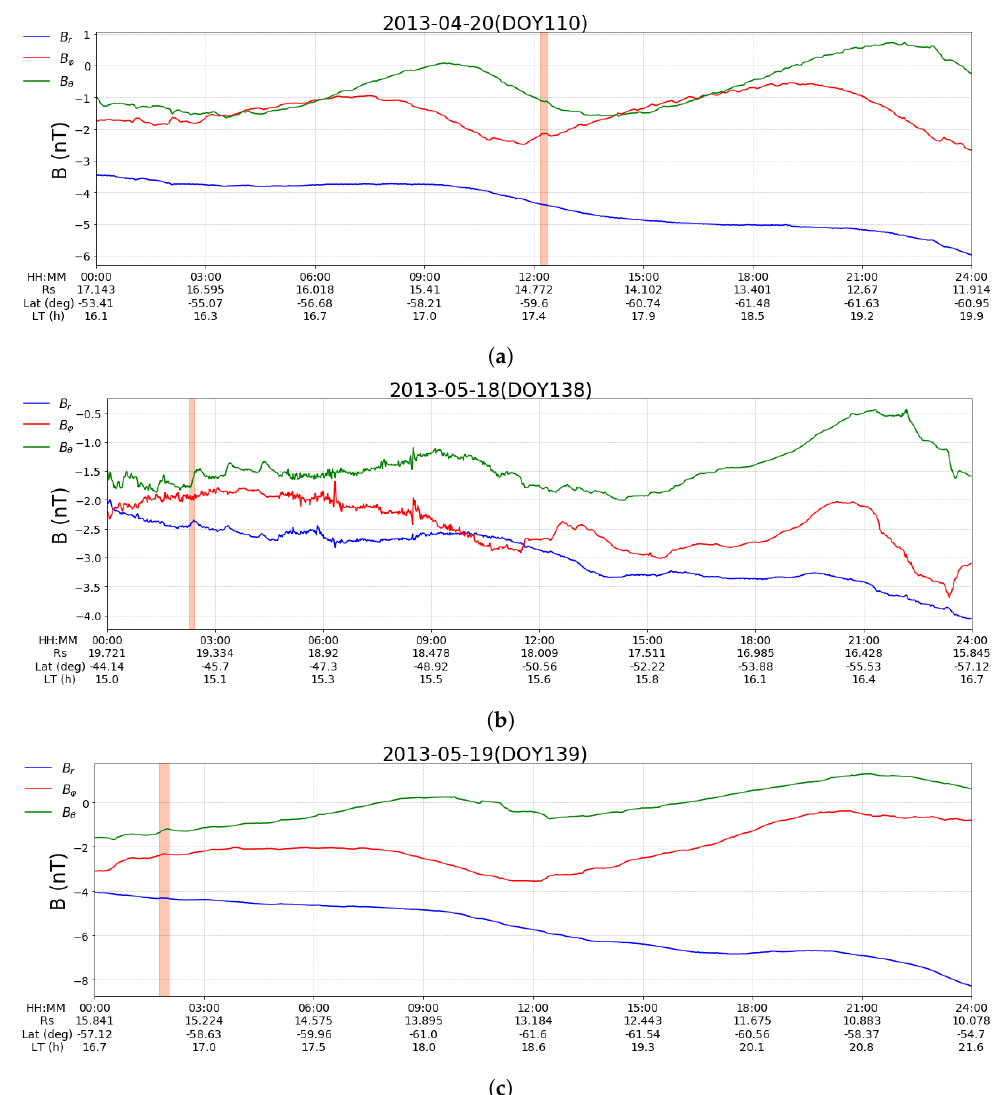
Figure 2. Magnetic field measurements in KRTP coordinates recorded by Cassini’s magnetometer. Orange shades represent the time when a transient flash was observed by the HST. ( a ): 2013-110; ( b ): 2013-138; ( c ):